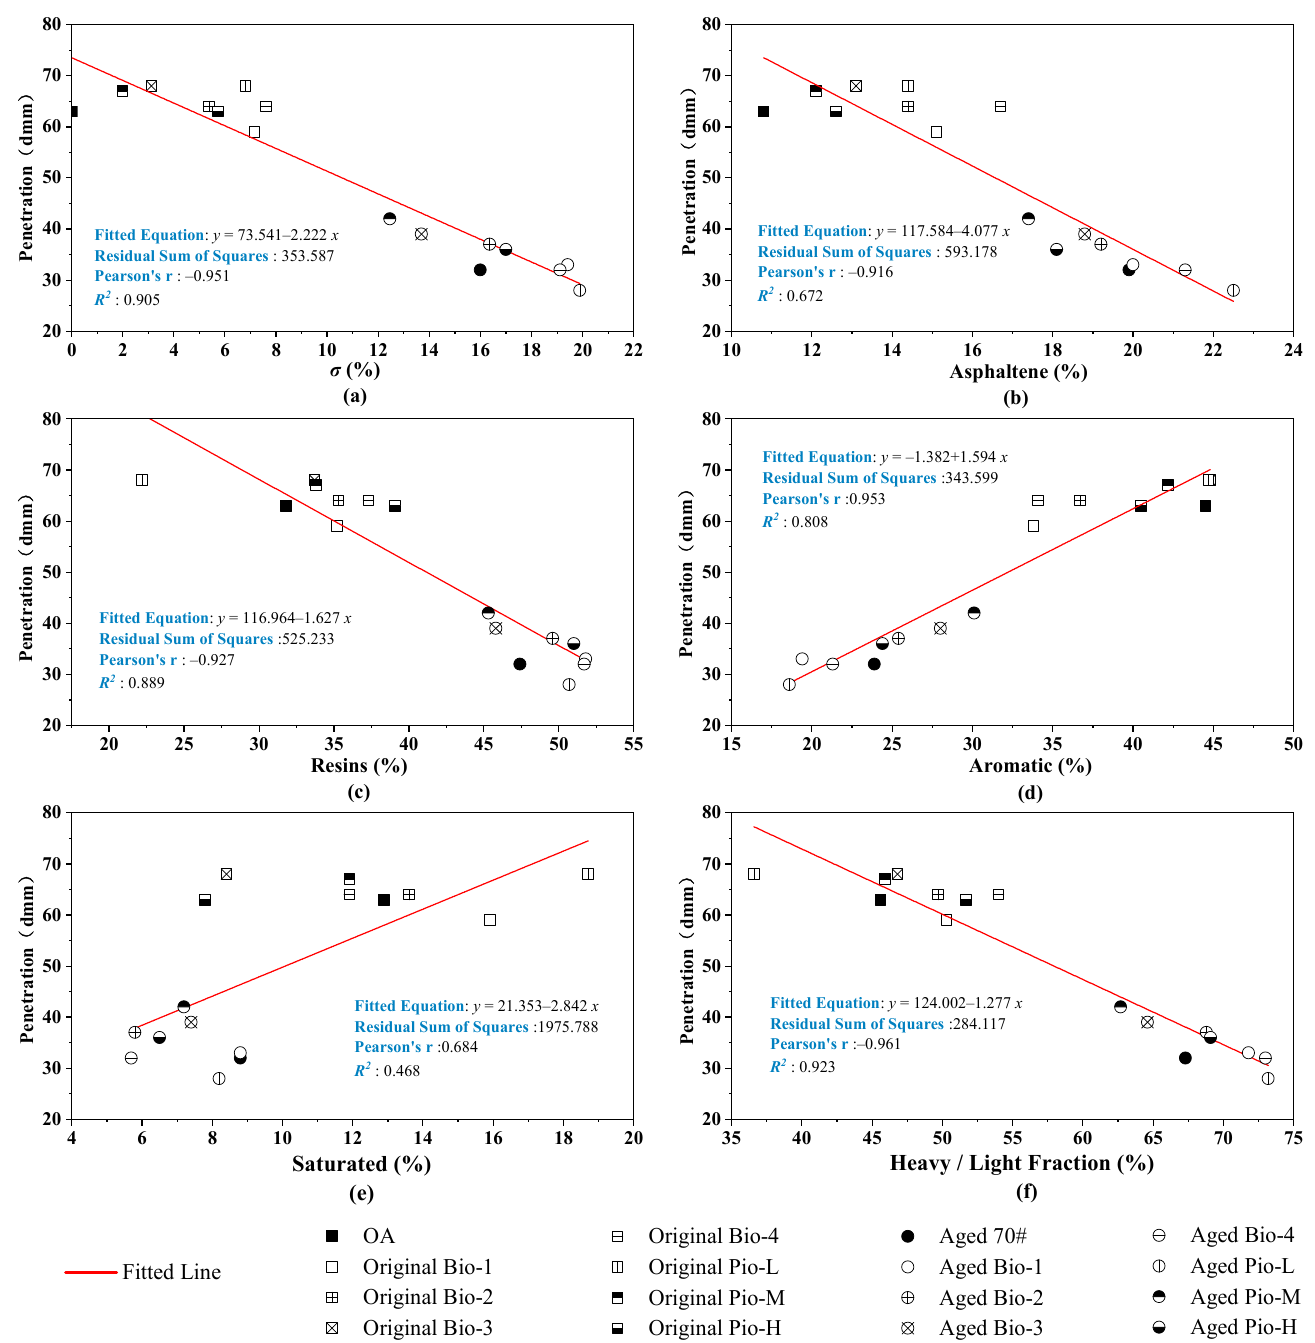
Figure 16. Correlation analysis between the penetration and fraction indicators. ( a ) σ ; ( b ) asphaltene; ( c )resins; ( d ) aromatic; ( e ) saturated; ( f ) heavy/light.